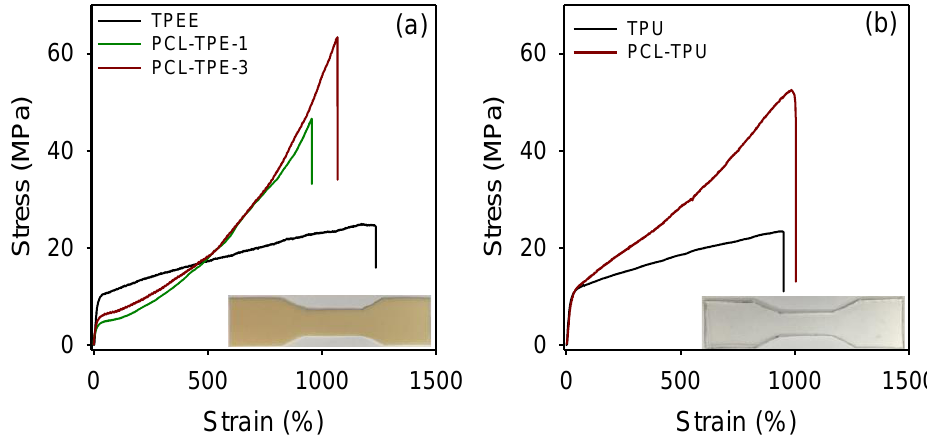
Figure 8. Stress–strain curves for ( a ) TPEs and ( b ) TPUs produced by different diols (conducted at a crosshead speed of 100 mm min −1 ).